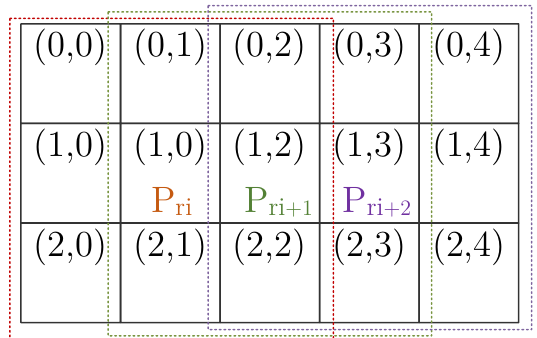
Figure 13. Census transform with a reference